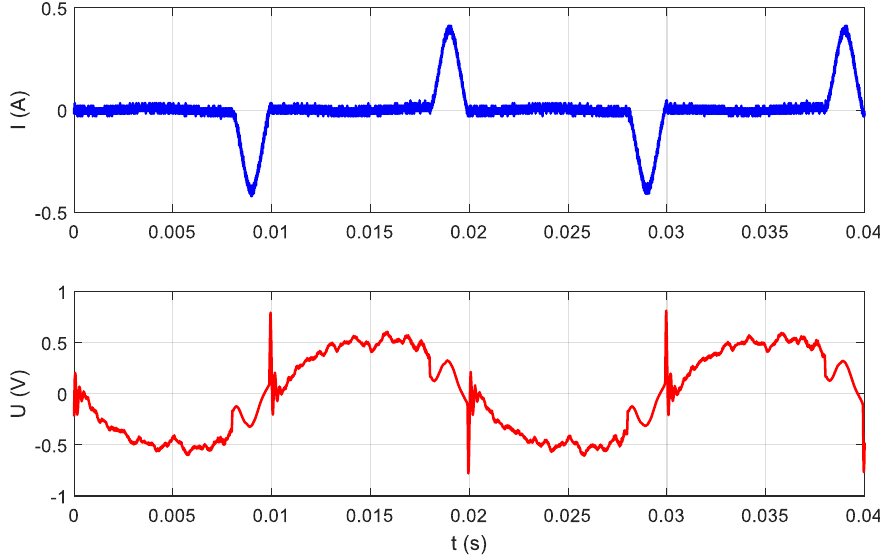
Figure 9. Current and high-pass (HP)-filtered voltage measured during LED bulb operation.